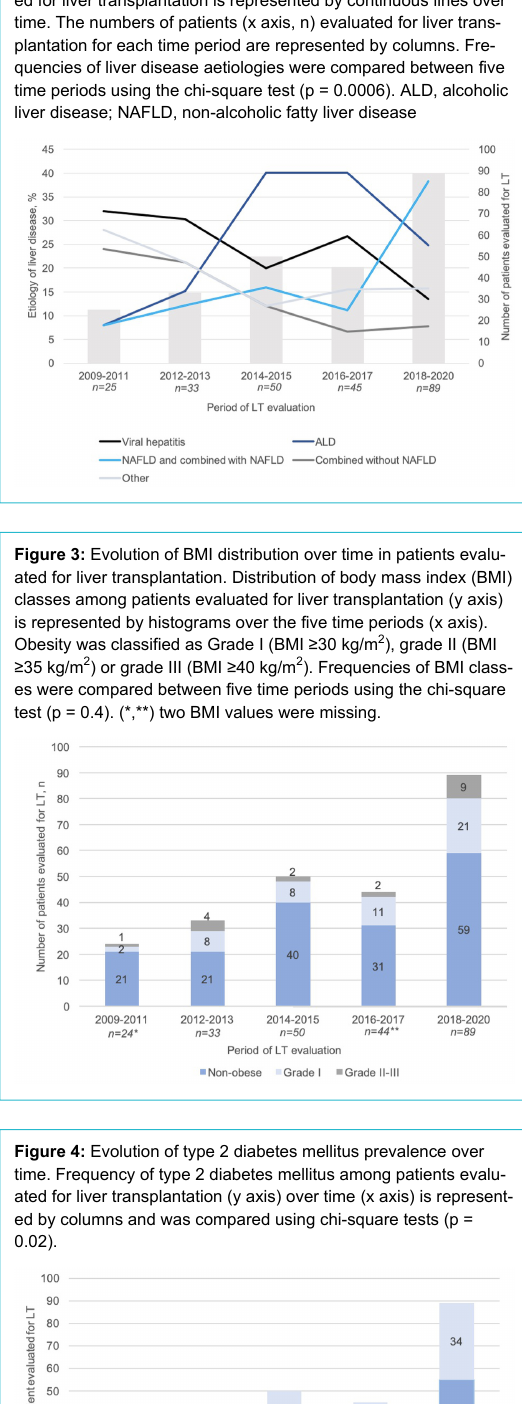
Figure 2: Aetiology of liver disease among patients evaluated for liver transplantation between January 2009 and March 2020. Fre- quency of liver disease causes (y axis, %) among patients evaluat- ed for liver transplantation is represented by continuous lines over time. The numbers of patients (x axis, n) evaluated for liver trans- plantation for each time period are represented by columns. Fre- quencies of liver disease aetiologies were compared between five time periods using the chi-square test (p = 0.0006). ALD, alcoholic liver disease; NAFLD, non-alcoholic fatty liver disease